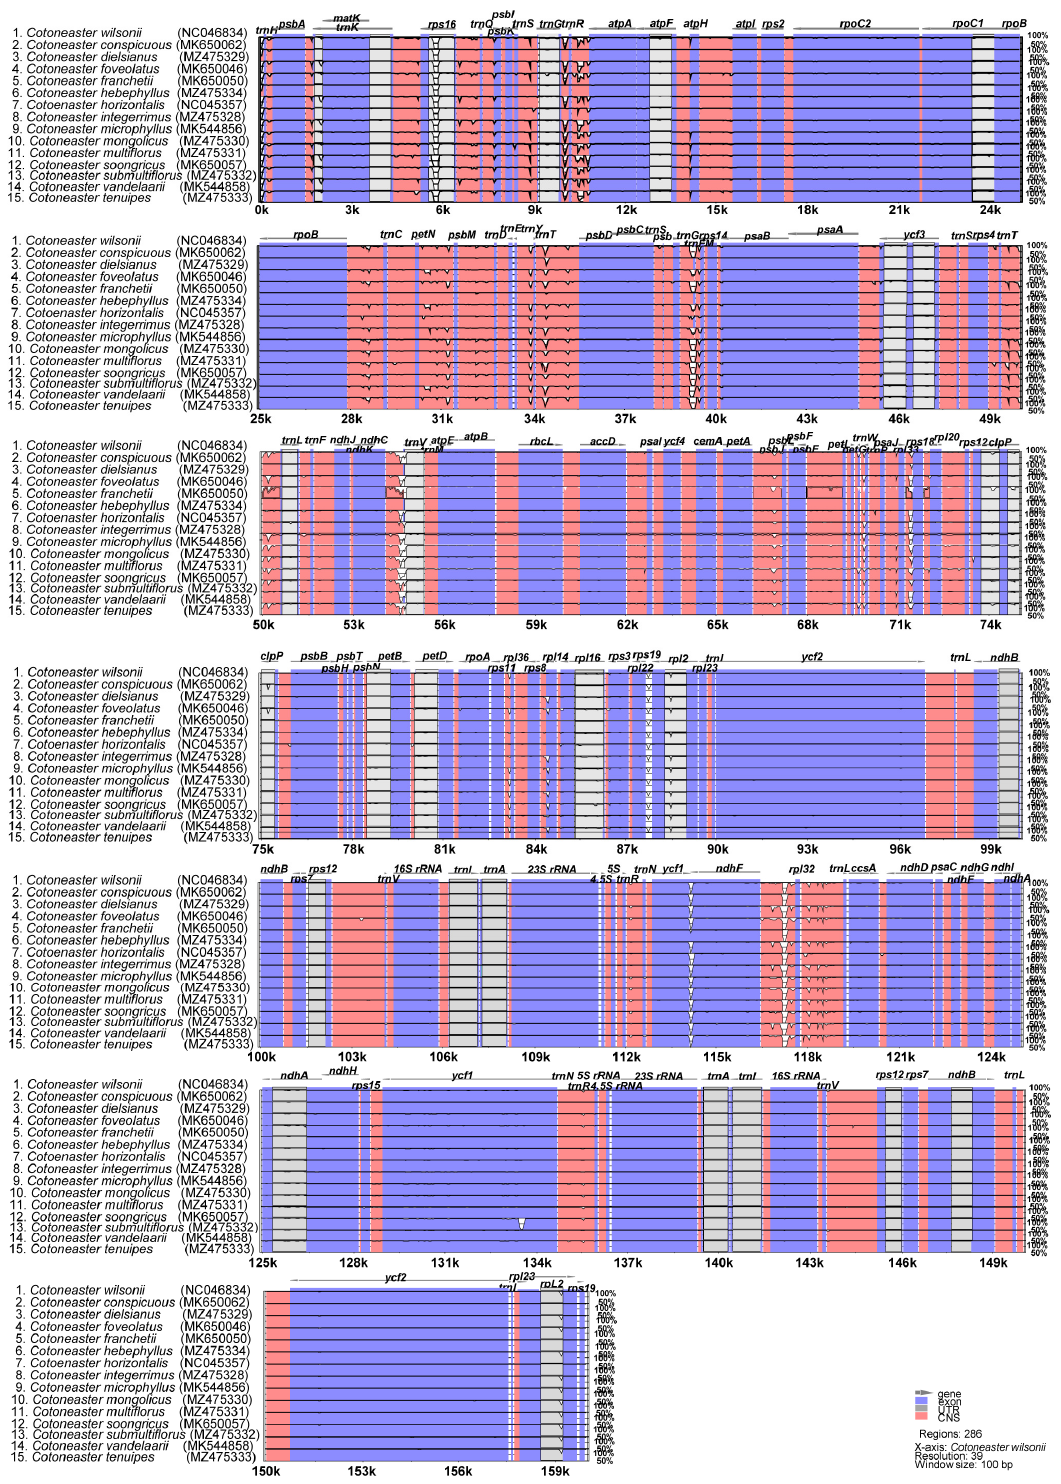
Figure 3. Visualization of alignment of the 15 plastome sequences of Cotoneaster species.